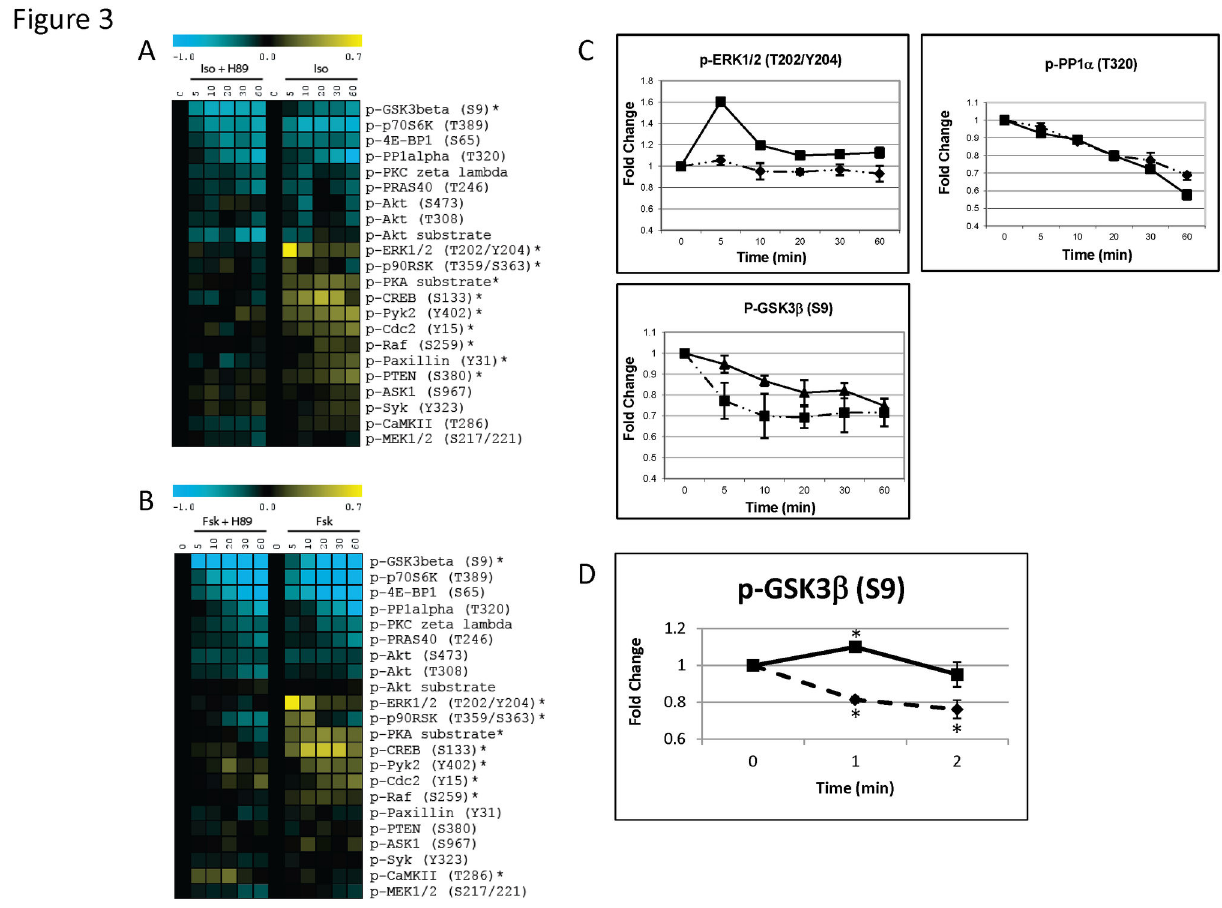
Figure 3. Isoproterenol- and forskolin-induced phosphoprotein signaling in the presence of the PKA inhibitor H89. A , MEFs were pretreated with H89 (10 μM) for 1 hour and then were stimulated with isoproterenol (Iso) (10 μM) for various times (0, 5, 10, 20, 30, or 60 minutes). The heat map shows phosphorylation (yellow) and dephosphorylation (blue) events after isoproterenol stimulation. The color scale shows fold change as compared with unstimulated MEFs. Data are means of three independent stimulation experiments. * denotes pathways that are significantly altered by pretreatment with H89 as assessed using the SAM algorithm. A two-class unpaired time course analysis was performed comparing signed-areas under the curve for each pathway. B , MEFs were pretreated with H89 as in (A) but were stimulated with forskolin (50 μM). Data are means of three independent stimulation experiments. * denotes pathways that are significantly altered by pretreatment with H89 as assessed using the SAM algorithm. C , The phosphorylation kinetics of ERK1/2(T202/Y204), PP1α(T320), GSK3β(S9) in response to isoproterenol (10 μM) stimulation in the presence (dashed line) or absence (solid line) of H89. The phosphorylation of ERK1/2(T202/Y204) is blocked by H89, dephosphorylation of PP1α(T320) is unchanged by H89, and dephosphorylation of GSK3β(S9) is enhanced by H89. Graphs show means ± SEM for three independent experiments. Values in the graph represent fold change as compared with unstimulated MEFs. D, Rapid phosphorylation kinetics of GSK3β(S9) by isoproterenol (10 μM) in the presence (dashed line) or absence (solid line) of H89. The graphs show means ± SEM of three independent experiments. * indicates a significant difference (P<0.05) from baseline phosphorylation level as determined using a Student’s